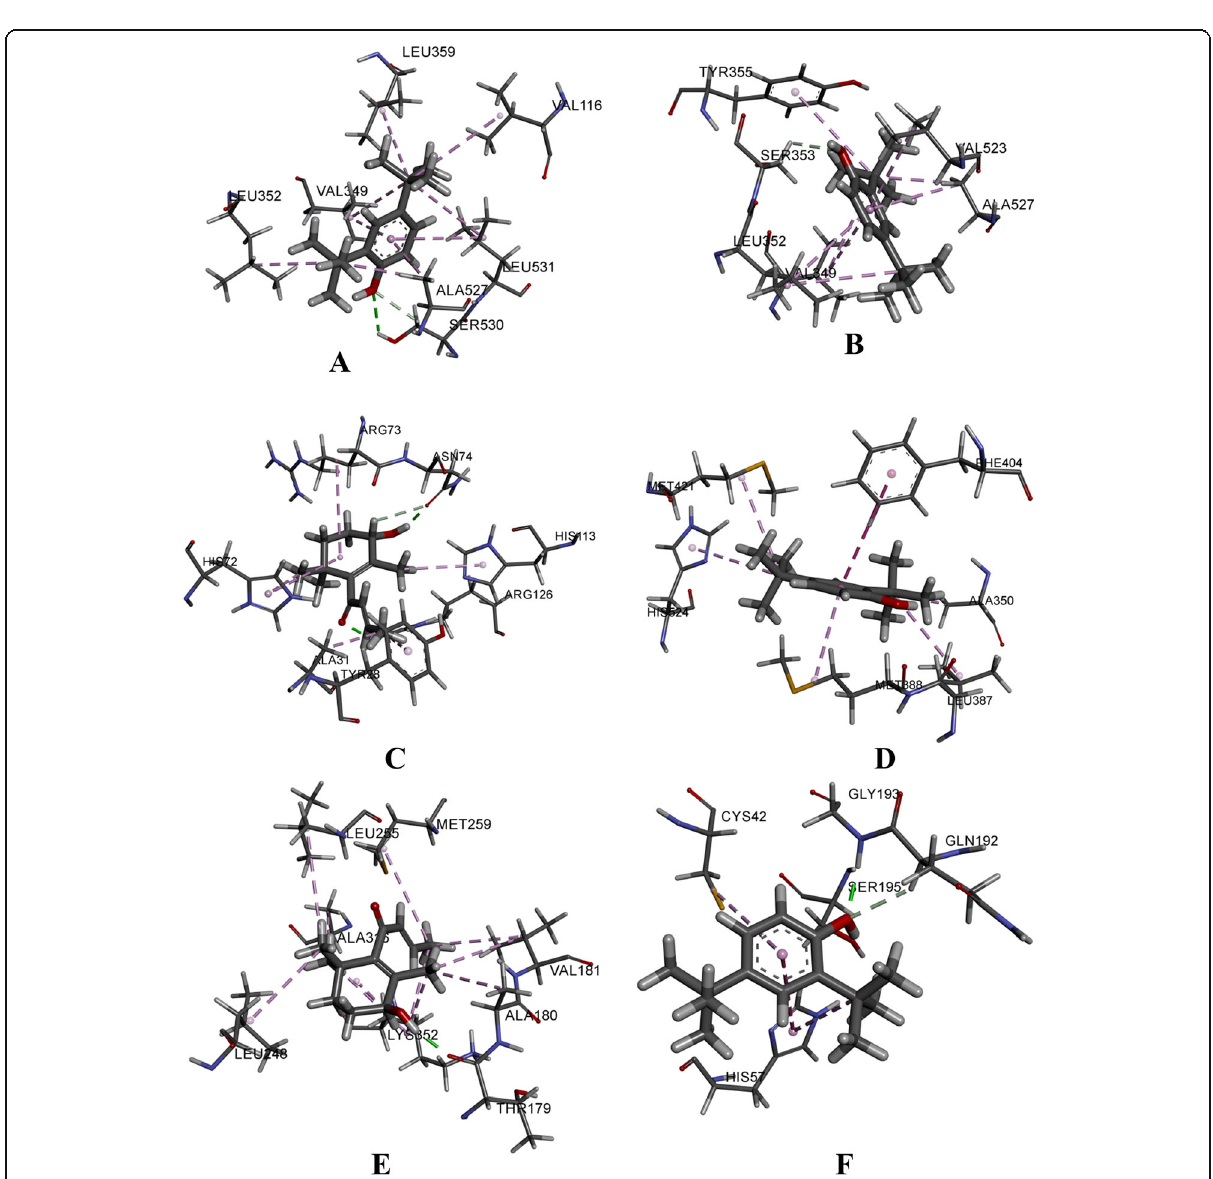
Fig. 6 3D representation of best docking score compounds. a 2,4-Ditert-butylphenol with COX1 receptor (PDB: 2OYE). b 2,4-Ditert-butylphenol with COX2 receptor (PDB: 6COX). c 3-Hydroxy- β -damascone with microsomal prostaglandin E synthase (mPGES)-1 (PDB: 3DWW). d 2-4-Ditert- butylphenol with human estrogen receptor (PDB: 1ERR). e 3-Hydroxy- β -damascone with tubulin-colchicine (PDB: 1SA0). f 2-4-Ditert-butylphenol with tissue plasminogen activator (PDB: